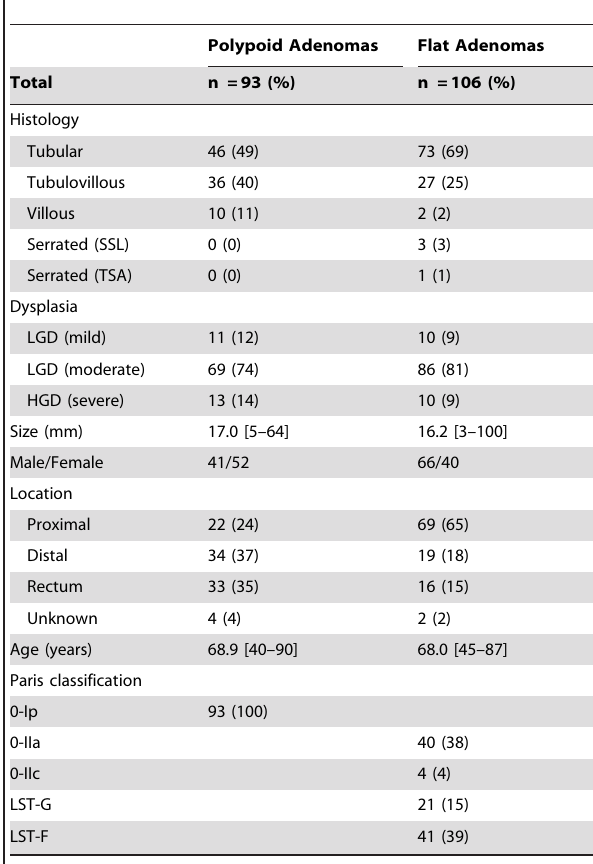
Table 1. Clinical characteristics of the 199 investigated